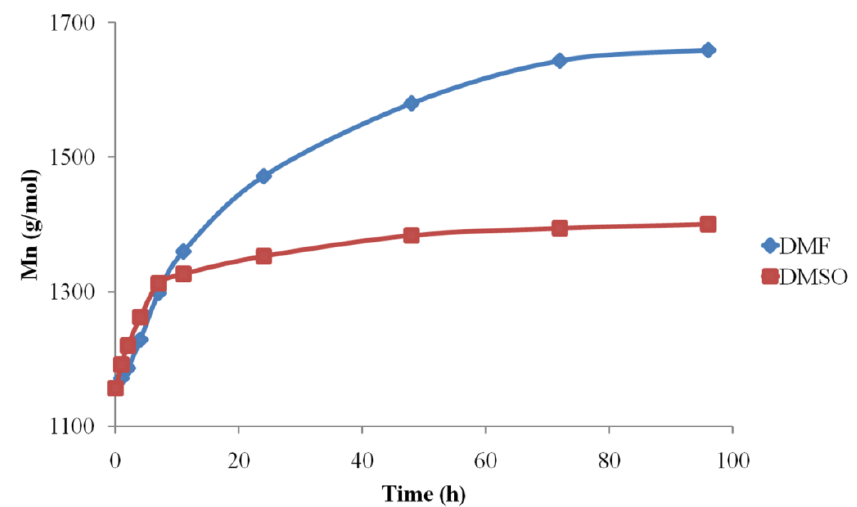
Figure 7. Solvent influence over M n evolution in the CD initiated ring-opening reaction of ε -CL (#1, 4) .